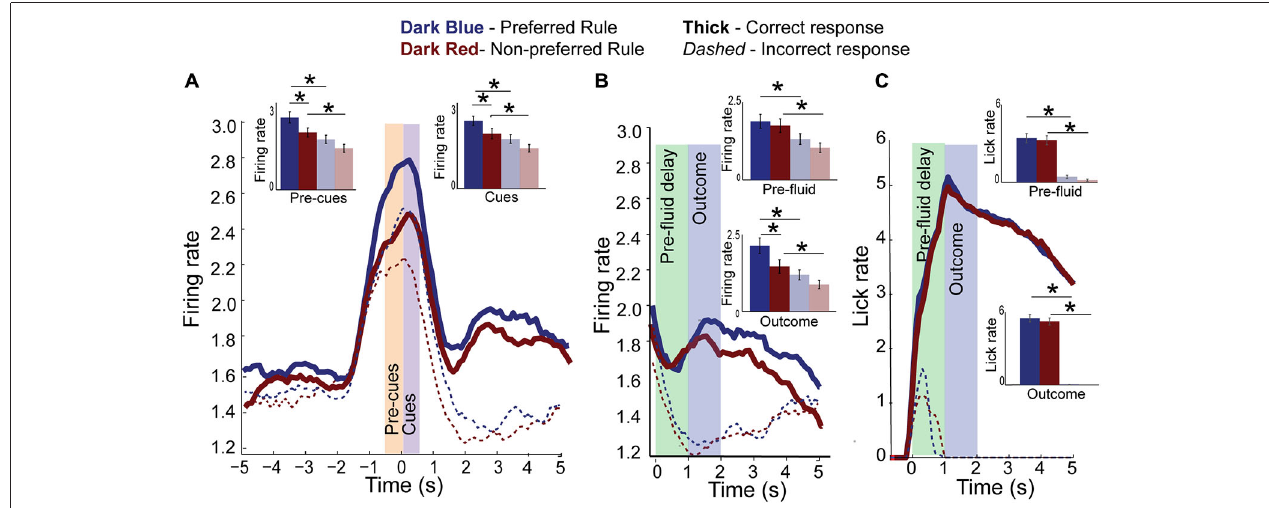
FIGURE 5 | Rule activity is diminished on error trials. (A) Population histogram of all rule-modulated neurons by preferred (dark blue) and non-preferred (dark red) rule blocks for correct (solid) and error (dashed) trials with inset bar graphs showing data from pre-cue and cue epochs for correct trials and error trials (faded blue and red bars). Though neural activity is the same as correct trials at baseline, it is significantly reduced during pre-cue and cue epochs. (B) Aligning the data from (A) to fluid-well entry and plotting pre-fluid delay and reward delivery epochs, we see that neural activity of rule-modulated neurons also reflects trial outcomes, being significantly reduced on error trials and highest during preferred rule correct trials. (C) Licking aligned to fluid well entry. Reward is delivered 1 s later on correct trials. Licking did not significantly differ between rules. Significance denoted of at least p < 0.05 with asterisk ∗ .